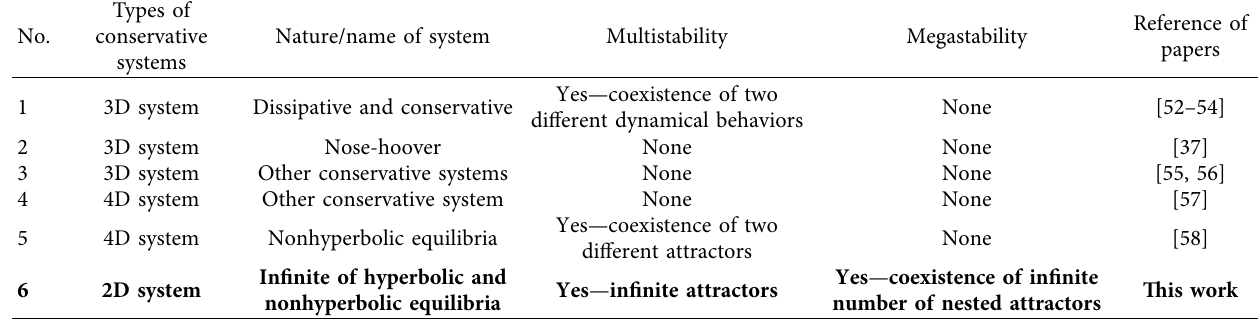
Table 2: Categorization of reported conservative chaotic systems with various characteristics.